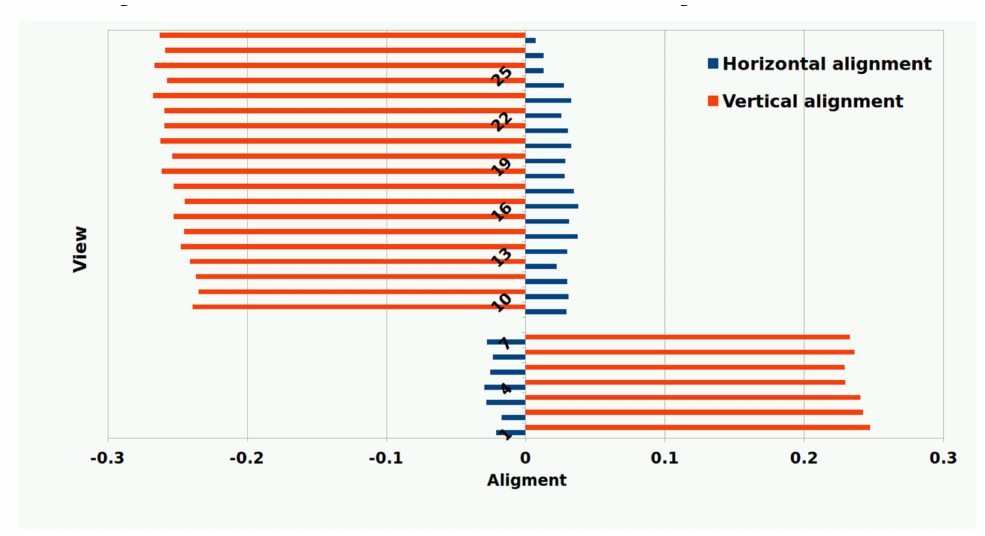
Figure 7. Records of the label-alignment parameters for 5778 images (214 × 27 views) from 214 scenes in the test dataset. It can be observed that the trend of vertical offsets from nadir to off-nadir along the flight direction of satellites is increasing, which demonstrates the effectiveness of label